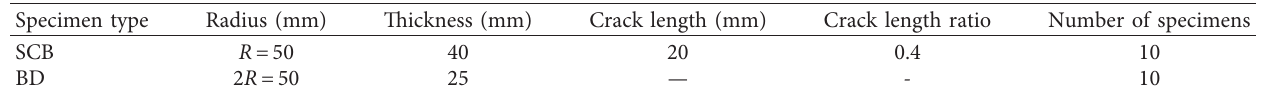
Figure 2: Schematic and real shots of two specimens. (a, c) SCB specimens. (b, d) Brazilian disc specimens (unit: mm). Table 1: Geometrical dimensions of specimens.